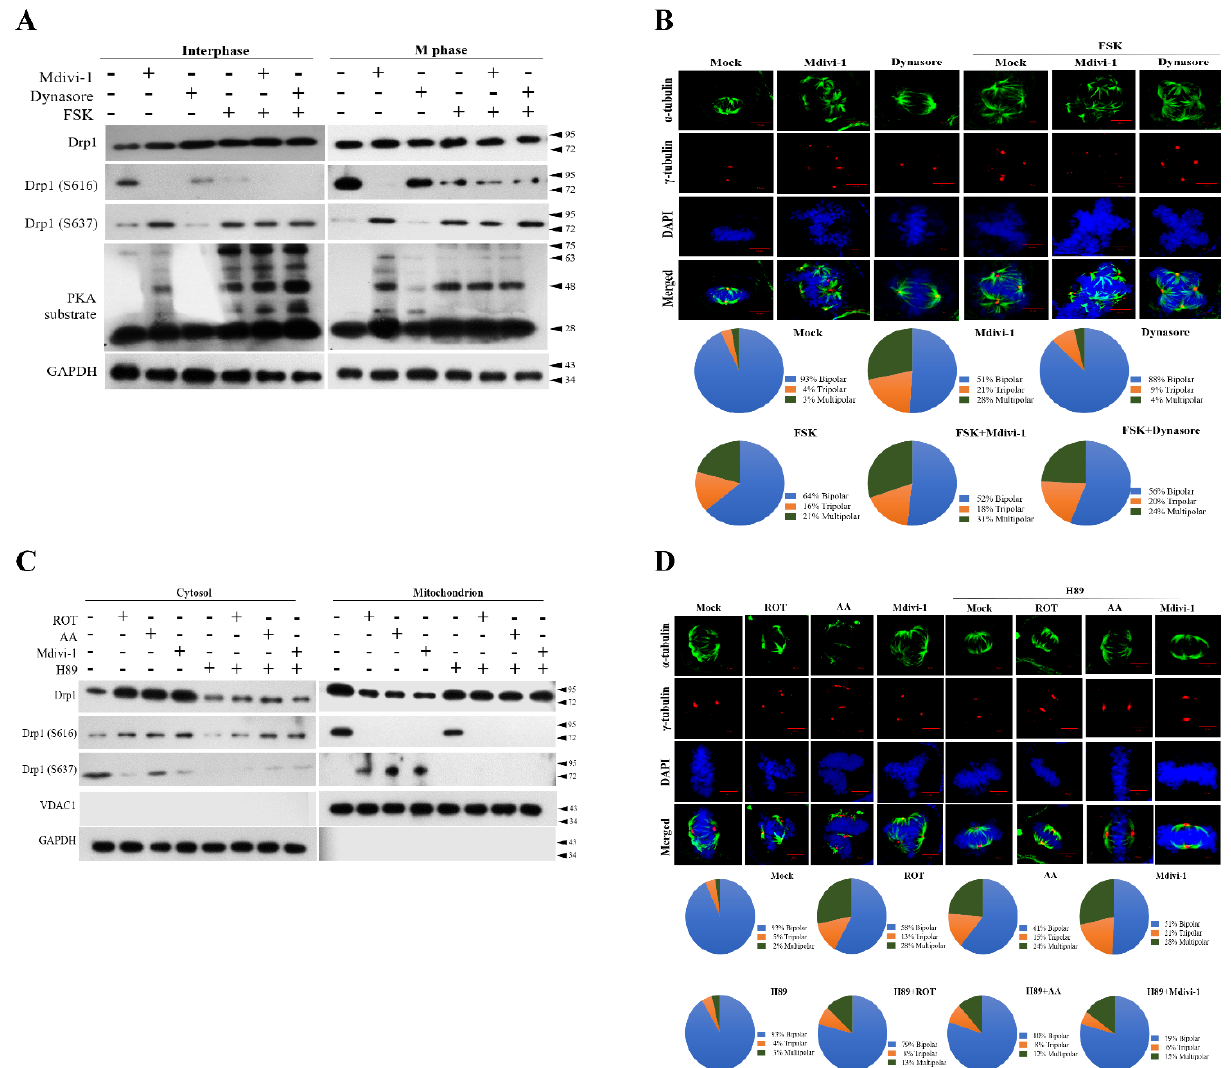
Figure 5. Blockade of mitochondrial ETC and morphological features by ROT, AA, Mdivi-1, and Dynasore along with the presence of FSK or H89 results in phosphorylation of Drp1-Ser637 and Drp1-Ser616 in PKA performance at mitosis. ( A ) FSK-enhanced Dynasore stimulated Drp1-dependent mitochondrial fission. ( B ) FSK-enhanced Dynasore induced multiple spindles formation. ( C ) H-89 suppressed the mito-Drp1-S637 phosphorylation induced by ROT, AA, and Mdivi-1. ( D ) H-89 inhibited multiple spindles formation induced by ROT, AA, and Mdivi-1. Cells were pretreated with the PKA inhibitor H89 (50 µ M) or PKA activator FSK (25 µ M) for 2 h, followed by the treatment with ROT, AA Mdivi-1, and Dynasore for 24 h; whole-cell lysates were then prepared and subjected to Western blot. Quantitation pie charts indicate the percentage of bipolar, tripolar, and multipolar mitotic cells. VDAC1 and GAPDH were used as mitochondria and cytosol markers, respectively. GAPDH was checked for subcellular purity.